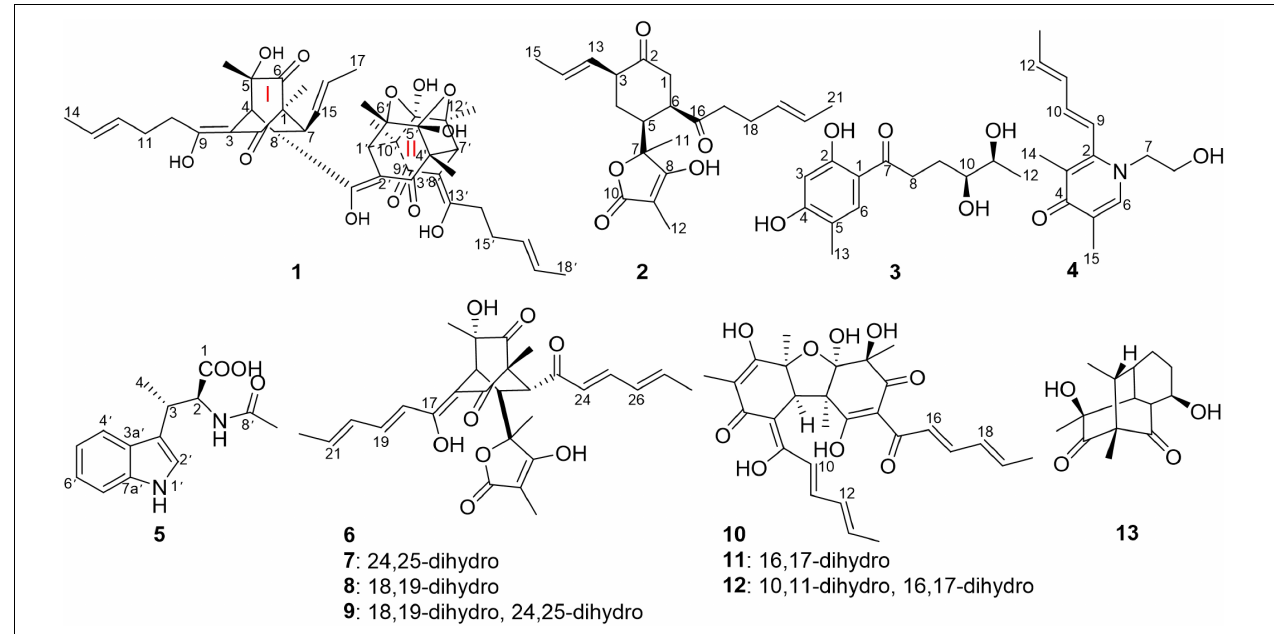
FIGURE 1 | Structures of compounds 1–13